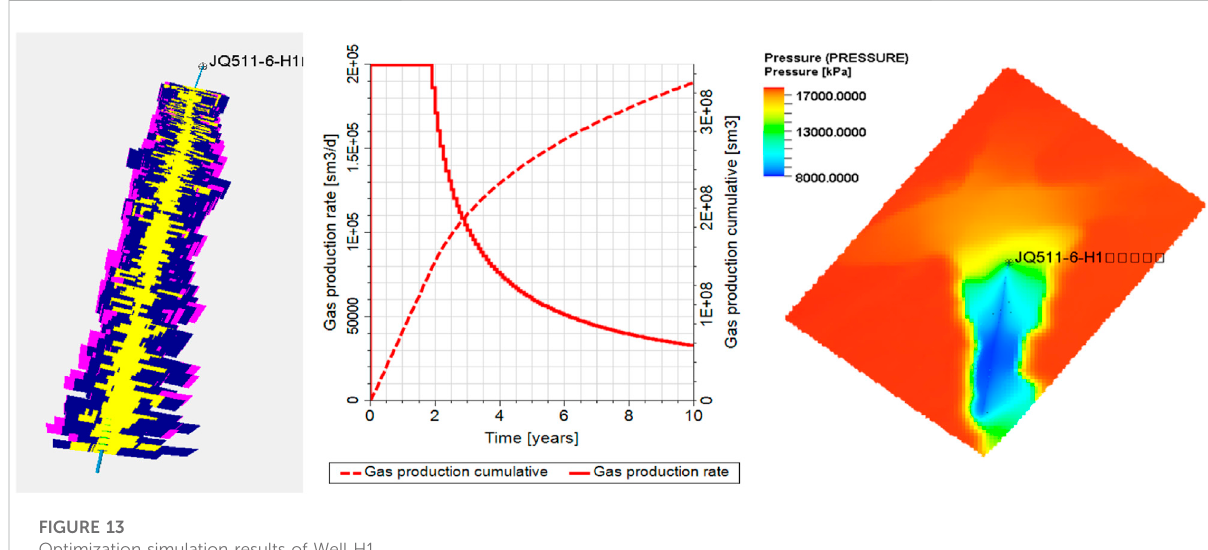
FIGURE 13 Optimization simulation results of Well H1.